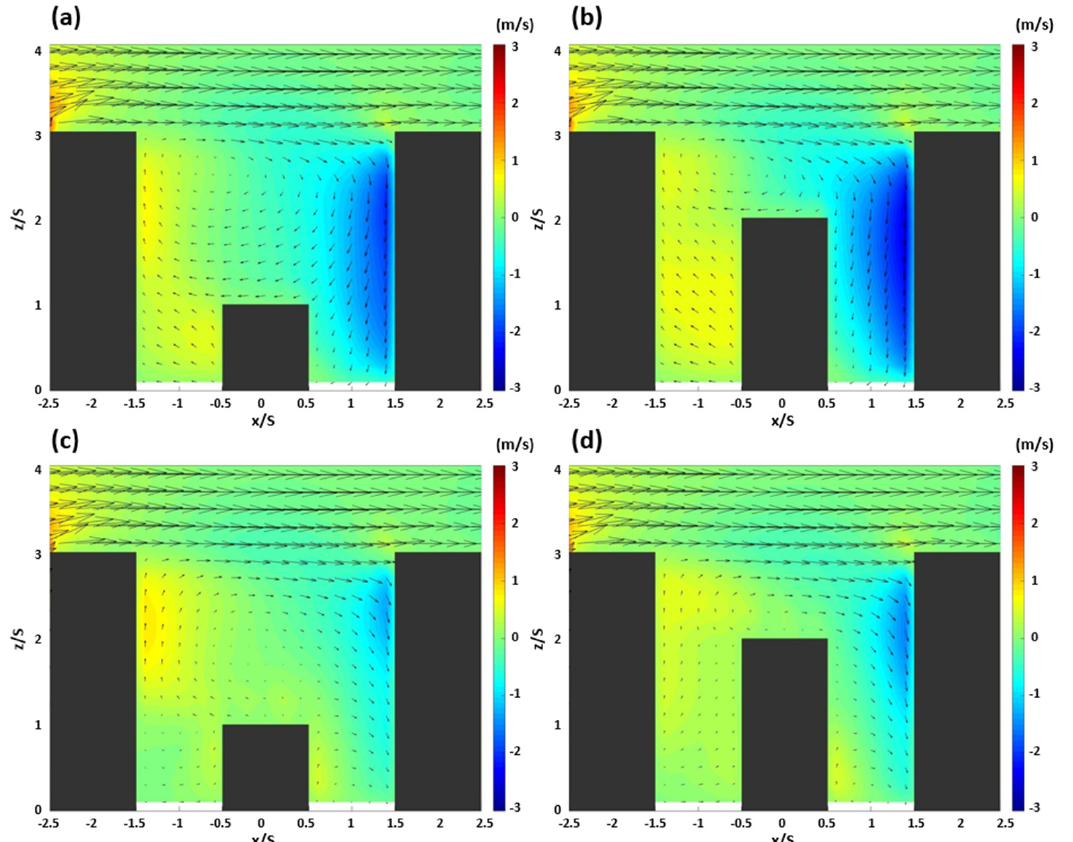
Figure 8. Wind field and vertical wind component of y/S = 0 (upper panel) and y/S = 0.3 and − 0.3 (lower panel) with numerical simulations in the cases of shallow canyons ( a , c ) and deep canyons ( b , d ).